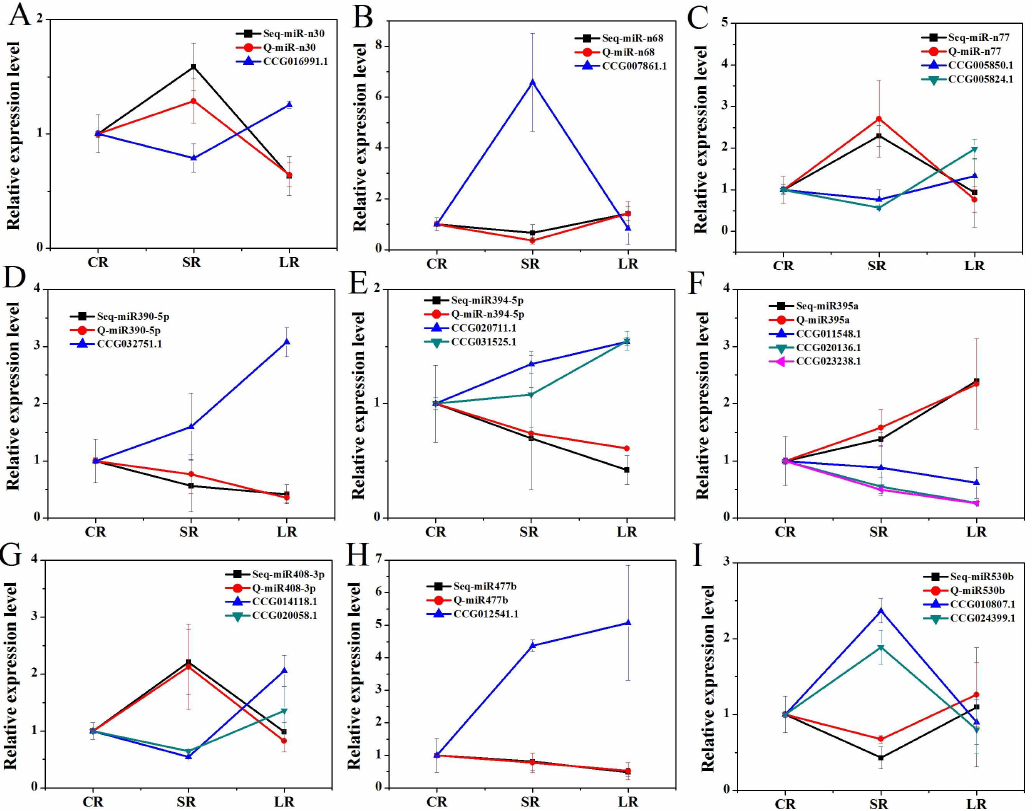
Figure 9. The expression profiles of predicted target genes and their corresponding miRNAs using RT-qPCR. The level of every gene in the control was set at 1.0. Error bars represent the standard deviation of three replicates. “Seq” means the results of high-throughput sequence, “Q” means the results of RT-qPCR. ( A ) The relative expression of miR-n30 with the predicted target CCG016991.4 (Potri.004G211300); ( B ) the relative expression of miR-n68 with the predicted target CCG007861.1 (Potri.009G090700); ( C ) the relative expression of miR-n77 with the predicted targets CCG005850.1 (Potri.005G225600) and CCG005824.1 (Potri.005G171700); ( D ) the relative expression of miR390-5p with the predicted target CCG032751.1 (Potri.010G176000); ( E ) the relative expression of miR394-5p with the predicted targets CCG020711.1 (Potri.001G057100) and CCG031525.1 (Potri.003G171300); ( F ) The relative expression of miR395a with the predicted targets CCG011548.1 (Potri.008G159000), CCG020136.1 (Potri.012G001400) and CCG023238.1 (Potri.007G108900); ( G ) the relative expression of miR408-3p with the predicted targets CCG014118.1 (Potri.002G188000) and CCG020058.1 (Potri.014G049600); ( H ) the relative expression of miR477b with the predicted targets CCG012541.1 (Potri.012G093900) and CCG030622.1 (Potri.015G091200); and ( I ) the relative expression of miR530b with the predicted targets miR530b CCG010807.1 (Potri.014G099700) and CCG024399.1 (Potri.010G076700).